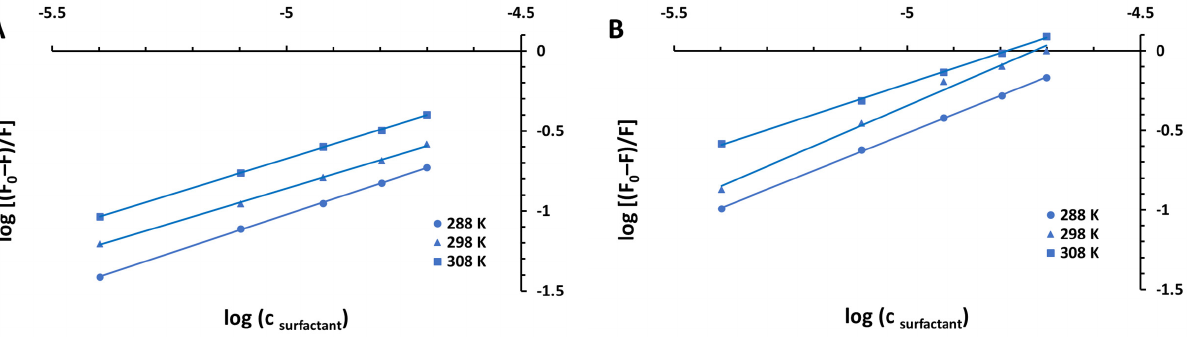
Figure 5. Modified Stern–Volmer plots for the steady-state fluorescence quenching of BSA by CPC in 10 mM CACO buffer of pH 5.0 ( A ) and 7.0 ( B ) at various temperatures (288 K, 298 K, and 308